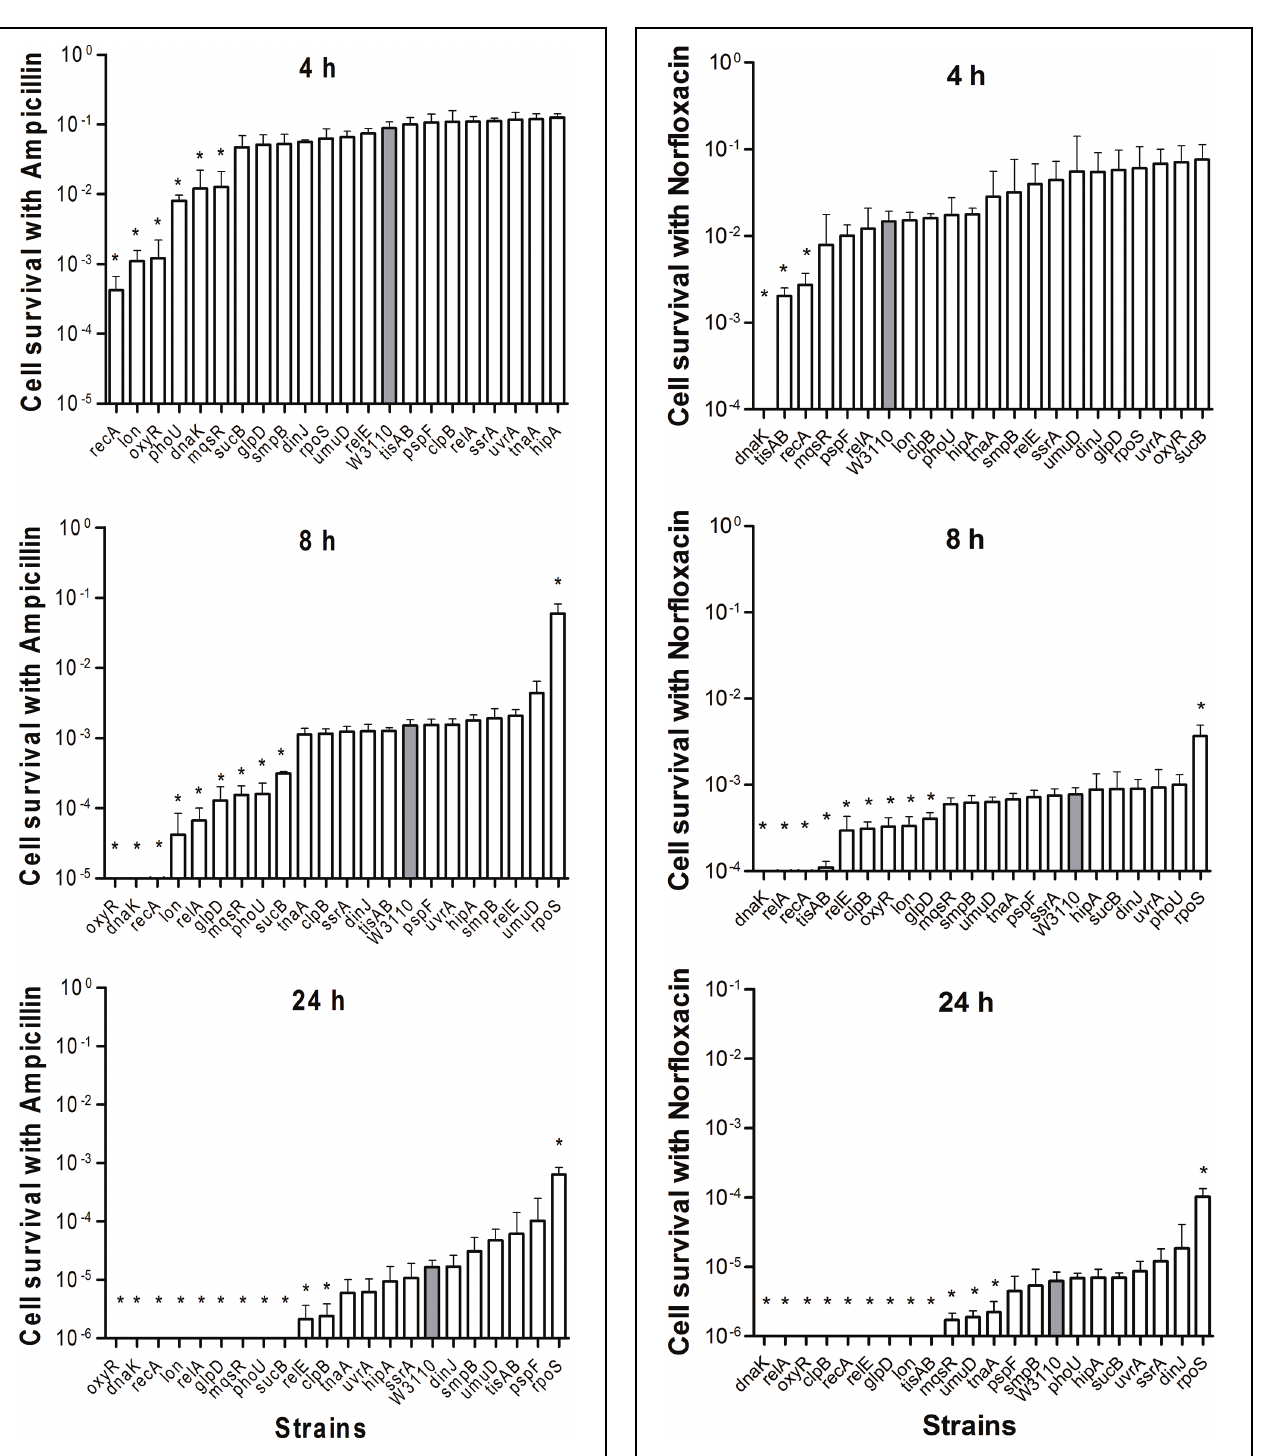
FIGURE 1 | Deletion mutant ranking depends on cell survival over time under conditions of ampicillin exposure. Stationary phase cultures of W3110 (gray bars) and single-gene mutants (white bars) were diluted 100-fold and exposed to 100 μ g/ml ampicillin for 4, 8, and 24 h. The data for each mutant was plotted and compared with that of W3110. Error bars indicate the standard deviation ( n = 3). The asterisk indicates statistical significance as determined using Mann–Whitney U tests ( ∗ P < 0.05).